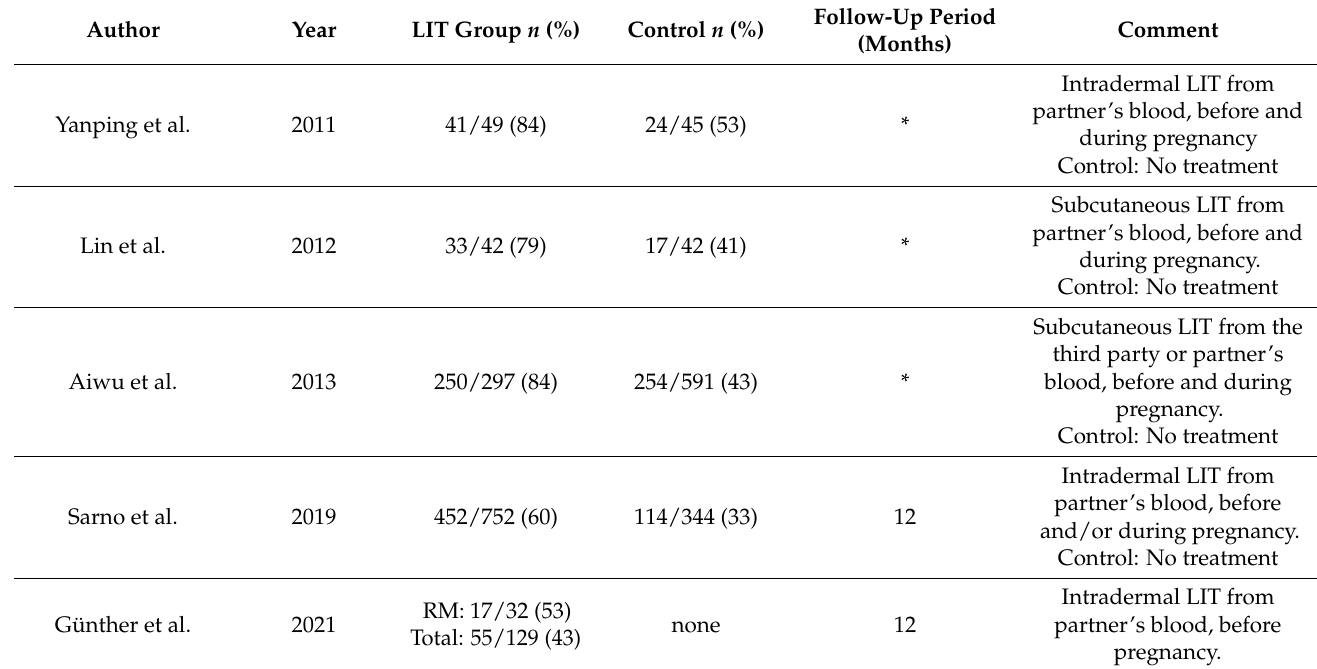
Table 4. Summary of selected studies included in the recent meta-analyses (Cochrane and Liu et al.) and data reported by Sarno et al. on live birth rates after LIT in couples with recurrent miscarriage in comparison to our